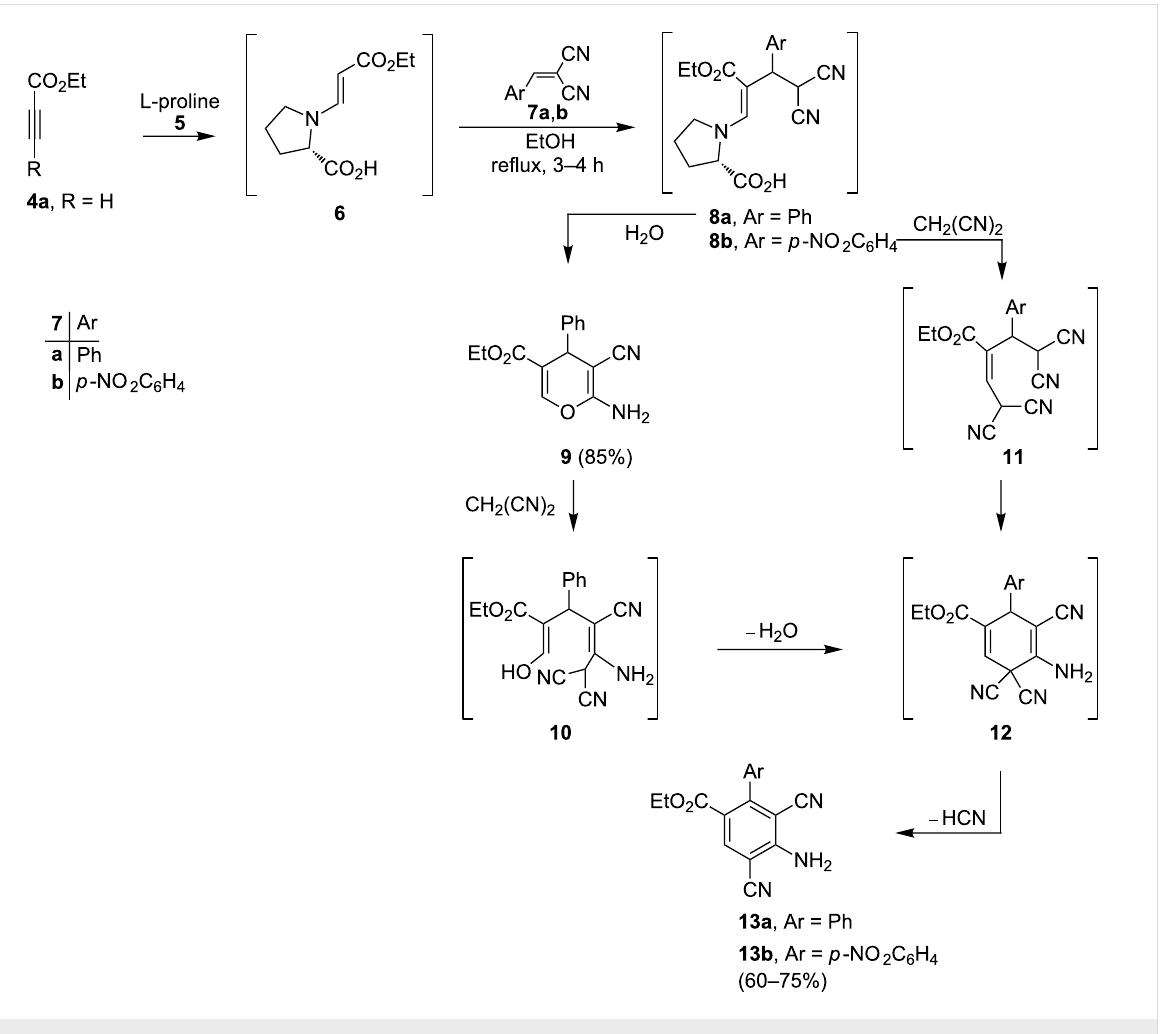
Scheme 4: Syntheses of compound 9 and compounds 13a , b .